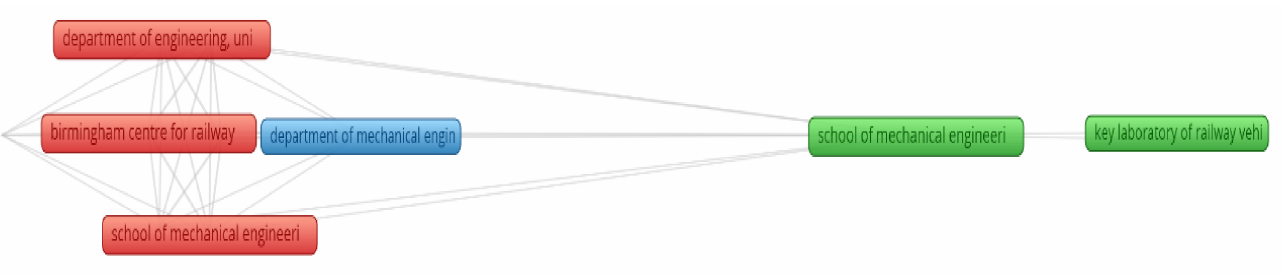
Figure 8. Organization collaboration.